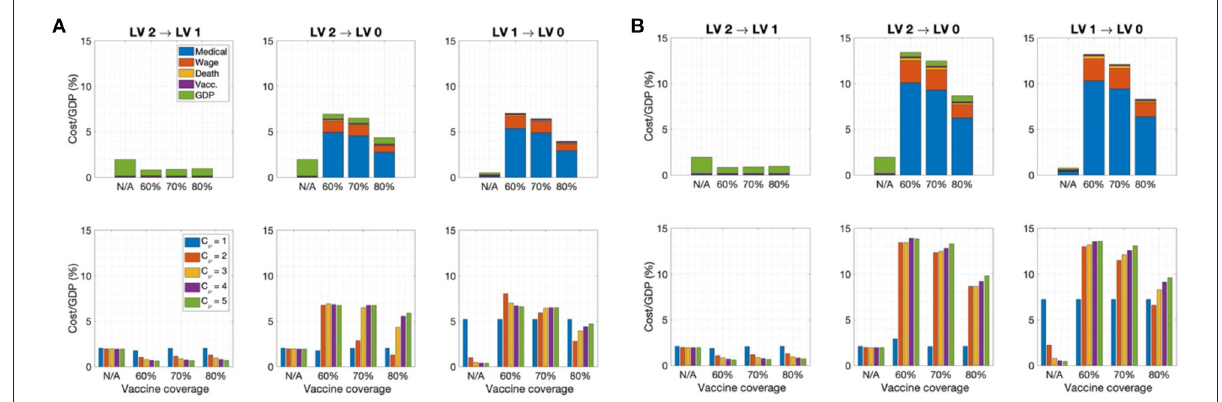
FIGURE5 Ratio of cost to GDP for each SD level mitigation scenario when the vaccination coverage rate reaches 60, 70, or 80% in case of admission to the treatment center for mild patients for (A) τ = 0.79 and (B) τ = 0.6 for (Top) C ν = 3. (Bottom) C ν = 1,2,...,5. (N/A indicates that social distancing easing was not implemented).